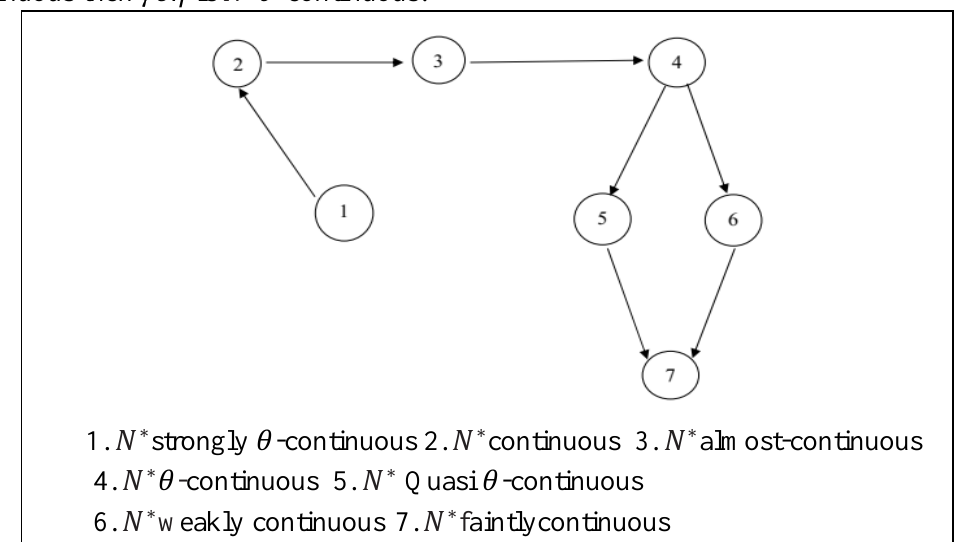
Figure 1. The relationship between 𝑁 ∗ 𝜃 -continuous maps and other continuous